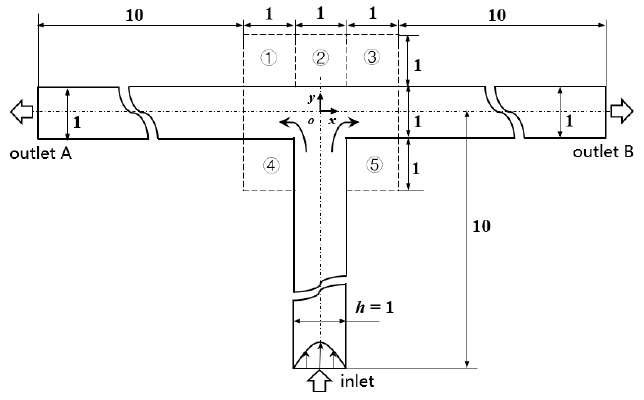
Table 3. Description of different channel structures and numerical